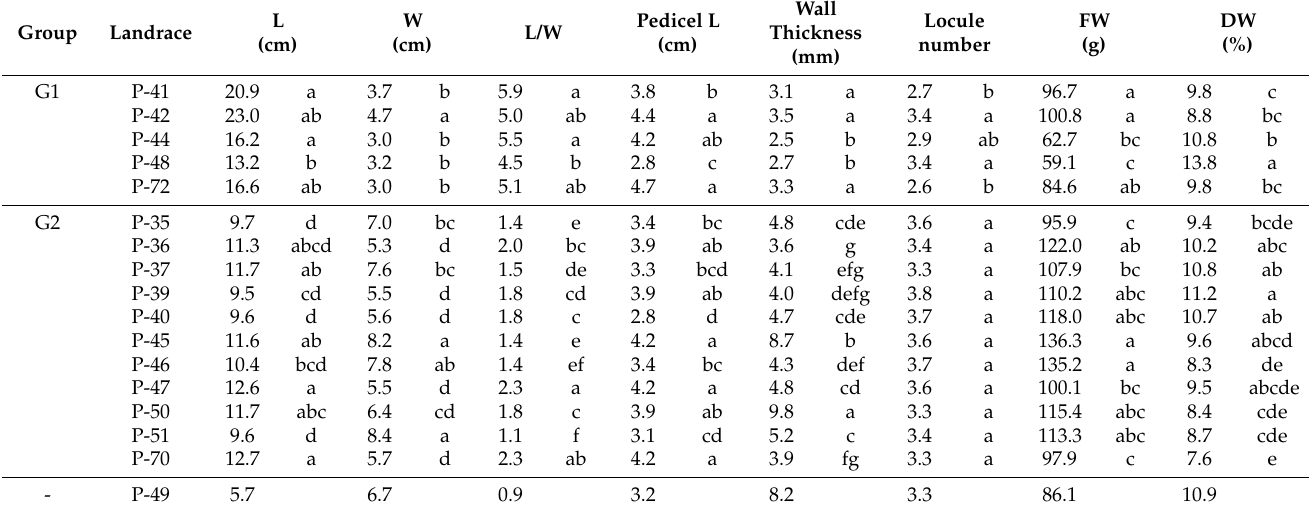
Table 4. Quantitative traits for conventional morphologic descriptors in red fruit of the 17 local pepper landraces cultivated in Spain. Statistics were performed by the formed groups based on fruit shape; G1 = elongated; G2 = triangular, square or blocky. Data belonging to the outlier ungrouped landrace (-, P-49 landrace) are also shown. For each landrace, values represent the mean for the studied conventional morphological descriptors ( n = 10 for fruit traits). Different letters in a group indicate significant differences at p ≤ 0.05 (LSD test). L: length; W: width; FW: fresh weight; DW: dry